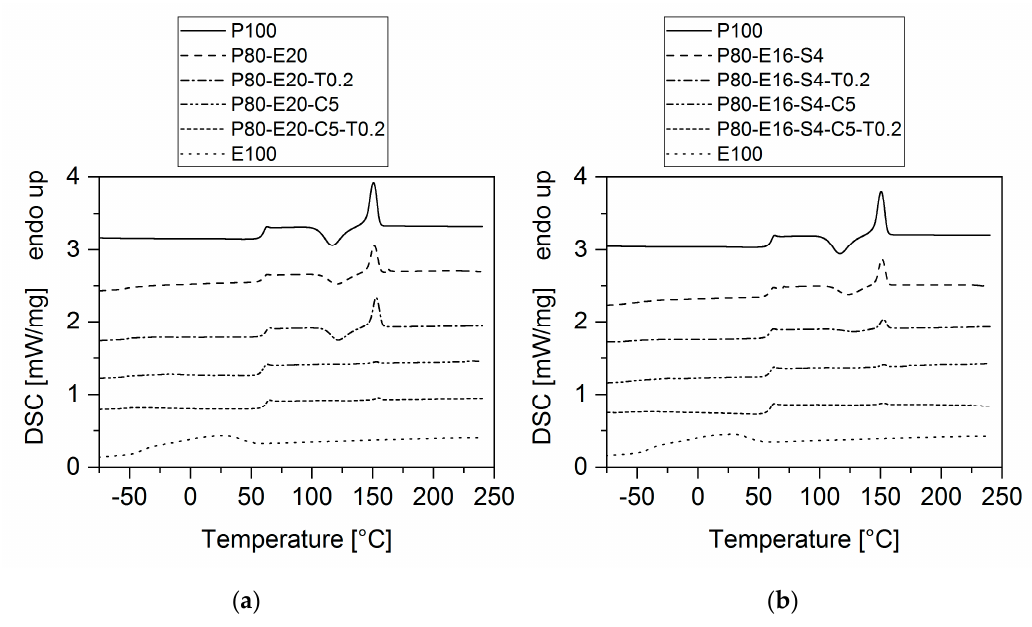
Figure 17. Second heating run of the di ff erential scanning calorimetry (DSC) measurements of the corresponding samples. ( a ) Samples without SBO and ( b ) samples with SBO. The curves have been shifted for better